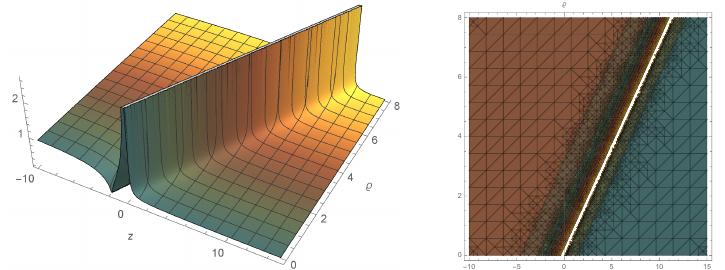
Figure 2. Three-dimensional (3D) and contour plots of the rational solution of Equation (18).